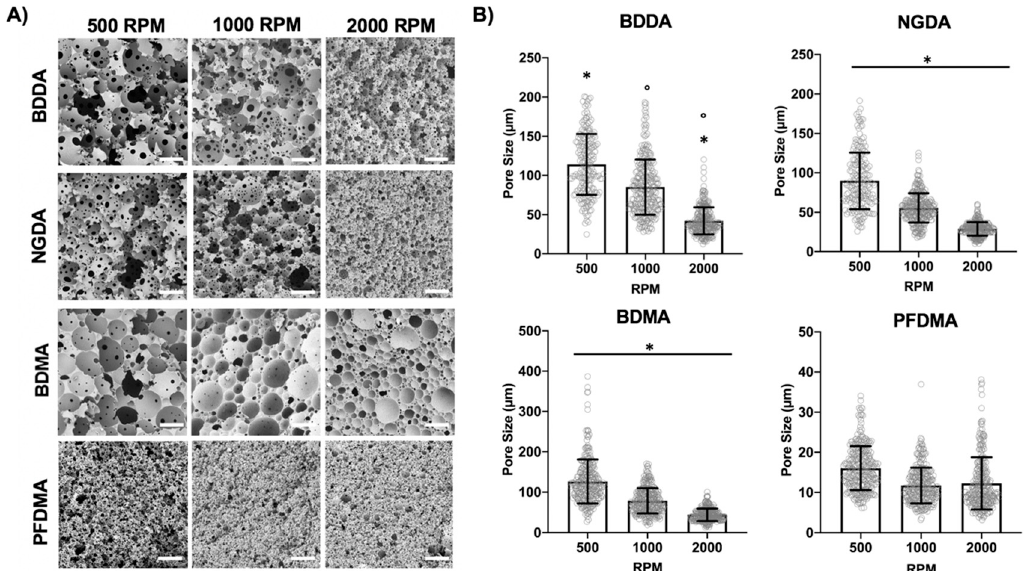
Figure 5. Representative scanning electron micrographs of fracture planes of BDDA, NGDA, BDMA, and PFDMA polyHIPEs fabricated at 500, 1000, and 2000 RPM ( A ) and the effect of increasing mixing speed on polyHIPE pore size for all four macromers ( B ). Scale bar is 100 µm. * and ° denotes statistical significance, p < 0.05.